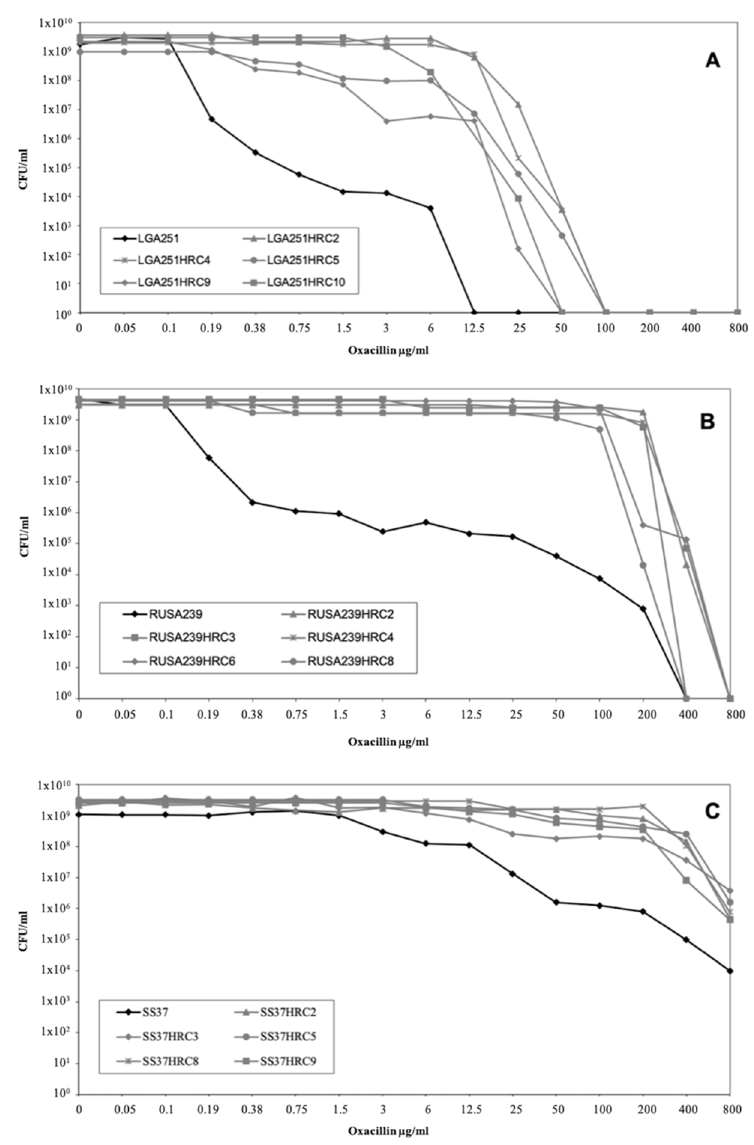
Figure 1. Population analysis profiles showing the different profiles between ( A ) LGA251, ( B ) RUSA239, and ( C ) SS37 parental heteroresistant populations (black lines) and the respective homoresistant (H*R) sub-populations (grey lines).